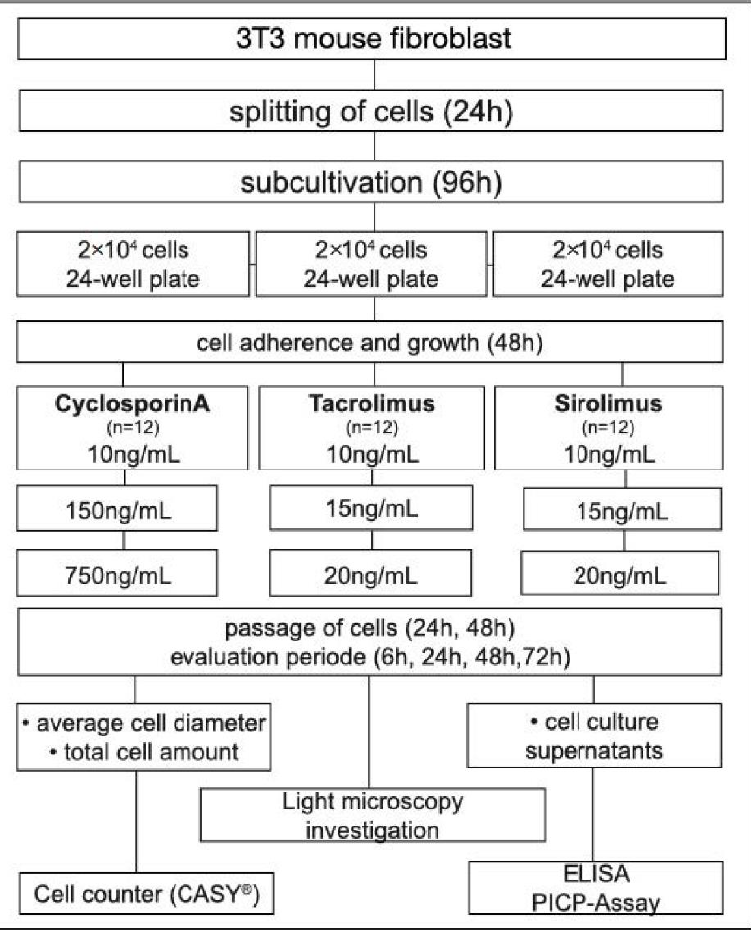
Figure 1. Flow chart of the experimental design.